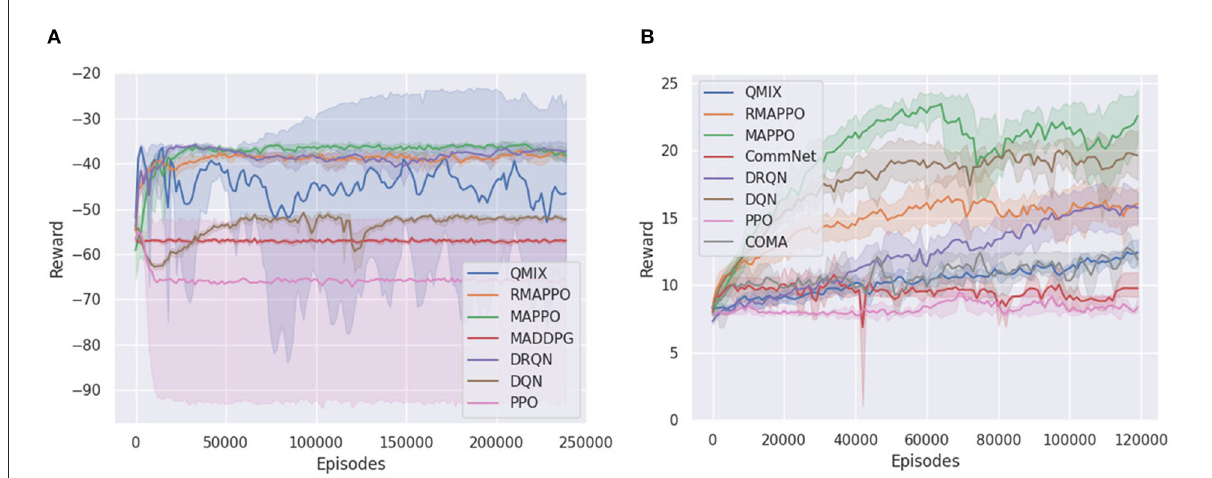
FIGURE1 Training curves of various algorithms in two cooperative environments. For every algorithm, the solid line represents the mean reward per episode, while the shaded region represents the 95% confidence interval around the mean. (A) Shows training curve for Simple Reference environment, (B) shows training curve for Space Invaders